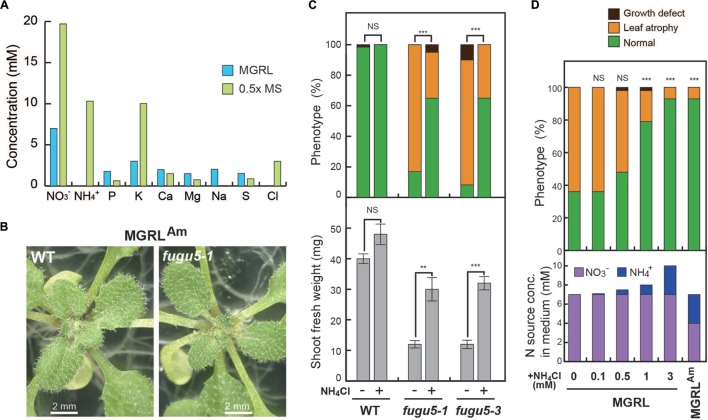
Leaf atrophy and growth defects of fugu5 grown on MGRL culture medium are recovered by the addition of NH4+.
(A) Macronutrient contents in the MGRL culture medium (light blue) and 0.5 × MS salt medium (light green). (B) Stereoscopic microscope images of WT and fugu5-1 grown on the MGRLAm culture medium, a modified MGRL supplemented with 3 mM NH4Cl and 3 mM KCl. (C) WT and mutants were grown on MGRL (NH4Cl,-) or MGRLAm (NH4Cl, +) plates for 3 weeks. Upper graph; phenotype distribution: normal plants (green), plants with leaf atrophy (dark yellow), and plants with growth defects (dark brown; n = 54–60). Lower graph; fresh weights of WT and mutant shoots grown on MGRL or MGRLAm plates. (D) Effect of NH4+ on recovery of growth defects of fugu5-1 mutants. fugu5-1 mutants were grown on MGRL culture medium supplemented with NH4Cl at the indicated concentrations. In this experiment, only NH4Cl was added and all other elements were unchanged. The frequencies of three phenotypic categories are shown in the upper graph (n = 42). Concentrations of NO3- (purple) and NH4+ (dark blue) are shown for each culture medium. Error bars show the SEs. Asterisks indicate significant differences at ∗∗P < 0.01 and ∗∗∗P < 0.005 compared with plants grown on MGRL plates [prop.test on upper graphs of (C,D); Student’s t-test on lower graph of (C); R ver. 3.1.2 (R Core Team, 2014)]. NS, not significant.